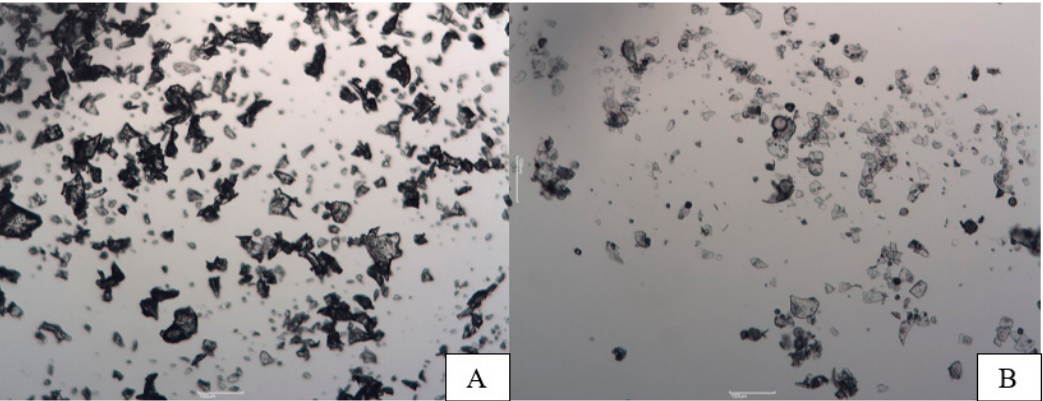
Figure 1. Structure of microcapsules (microscope magni fi cation 100 times, ( A )—LM microcapsules, ( B )—SDM microcapsules). ( B )—SDM